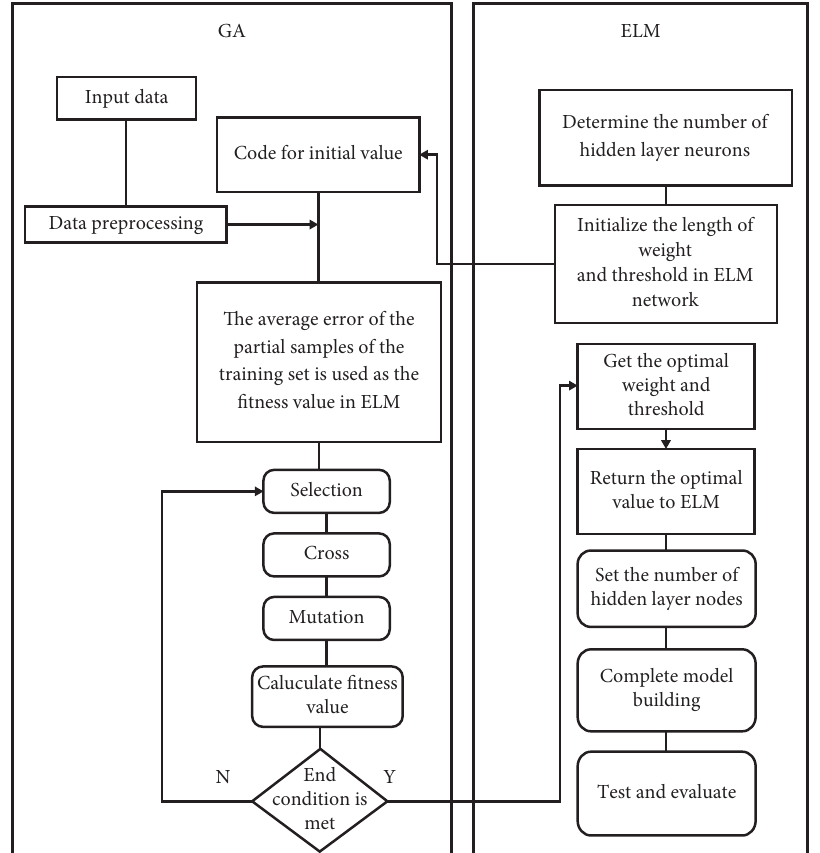
Figure 1: The algorithm flow of the GA-ELM